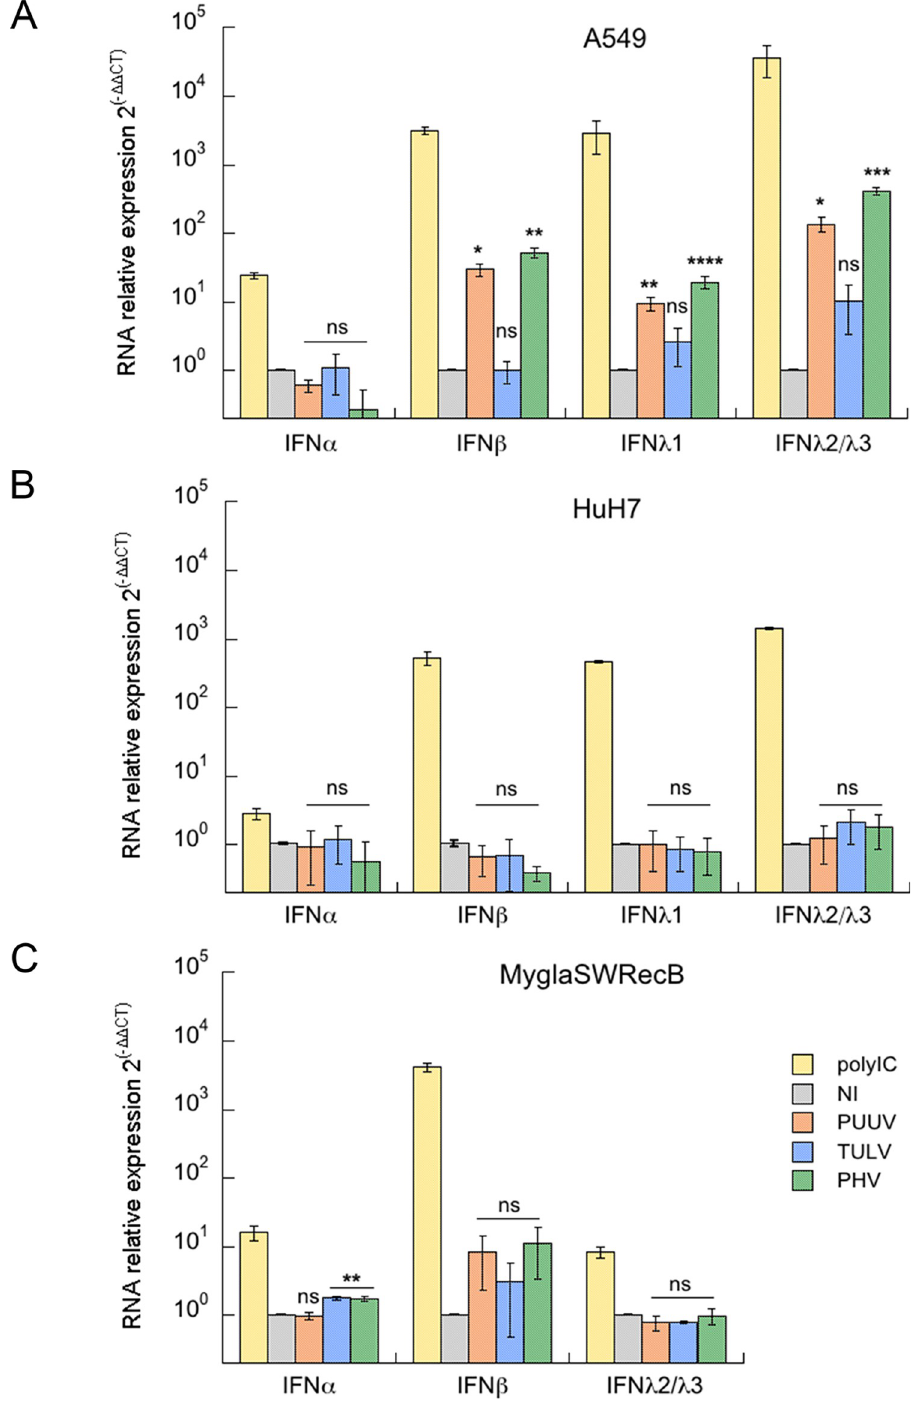
Fig 8. Regulation of IFN expression in infected human and bank vole cells. Human A549 (A) and HuH7 (B) cells and rodent MyglaSWRecB cells (C) were left non-infected (grey bars) or were infected with PUUV (orange bars), TULV (blue bars) or PHV (green bars) at a MOI of 0.5. As positive control, a condition where cells were treated with poly-IC was included (yellow bars). For each condition, the mRNA expression of the different IFN type I (IFN α and β ) and type III (IFN λ 1, λ 2 and λ 3), was compared with non-treated cells (2 - ΔΔ CT ) by RT-qPCR. Error bars correspond to the standard deviation from the mean determined from at least three replicates of three independent samples. Statistical analysis showed non-significant (ns) and significant variations relative to non-infected cells with p-values p < 0.0332 ( � ), p < 0.0021( �� ), p < 0.0002 ( ��� ) and p < 0.0001( ���� ).